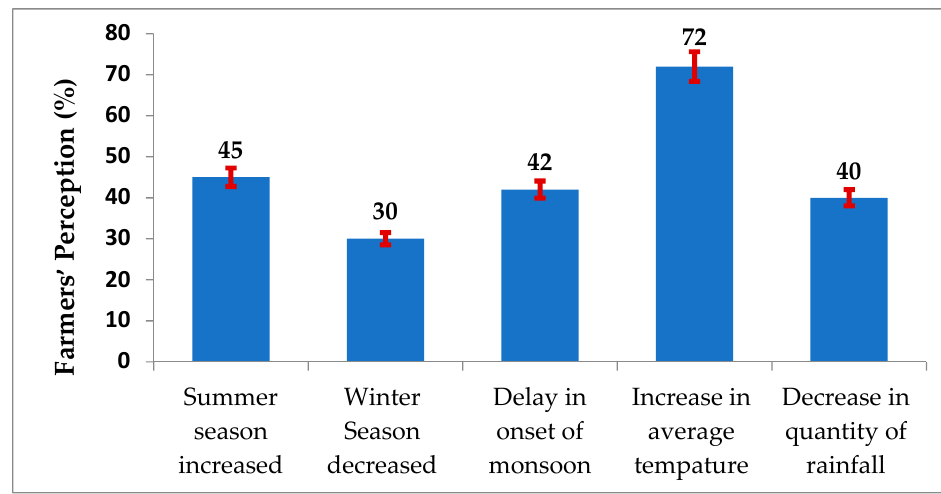
Figure 3. Farmers’ perceptions (%) about climate change.